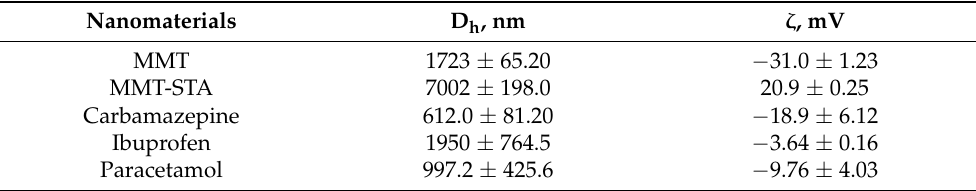
Table 1. The values of the hydrodynamic diameters (D h ) and zeta potentials (ζ) of the substances used.